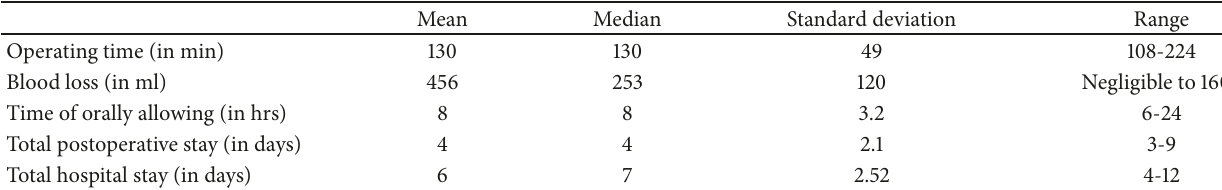
Table 1: Operative